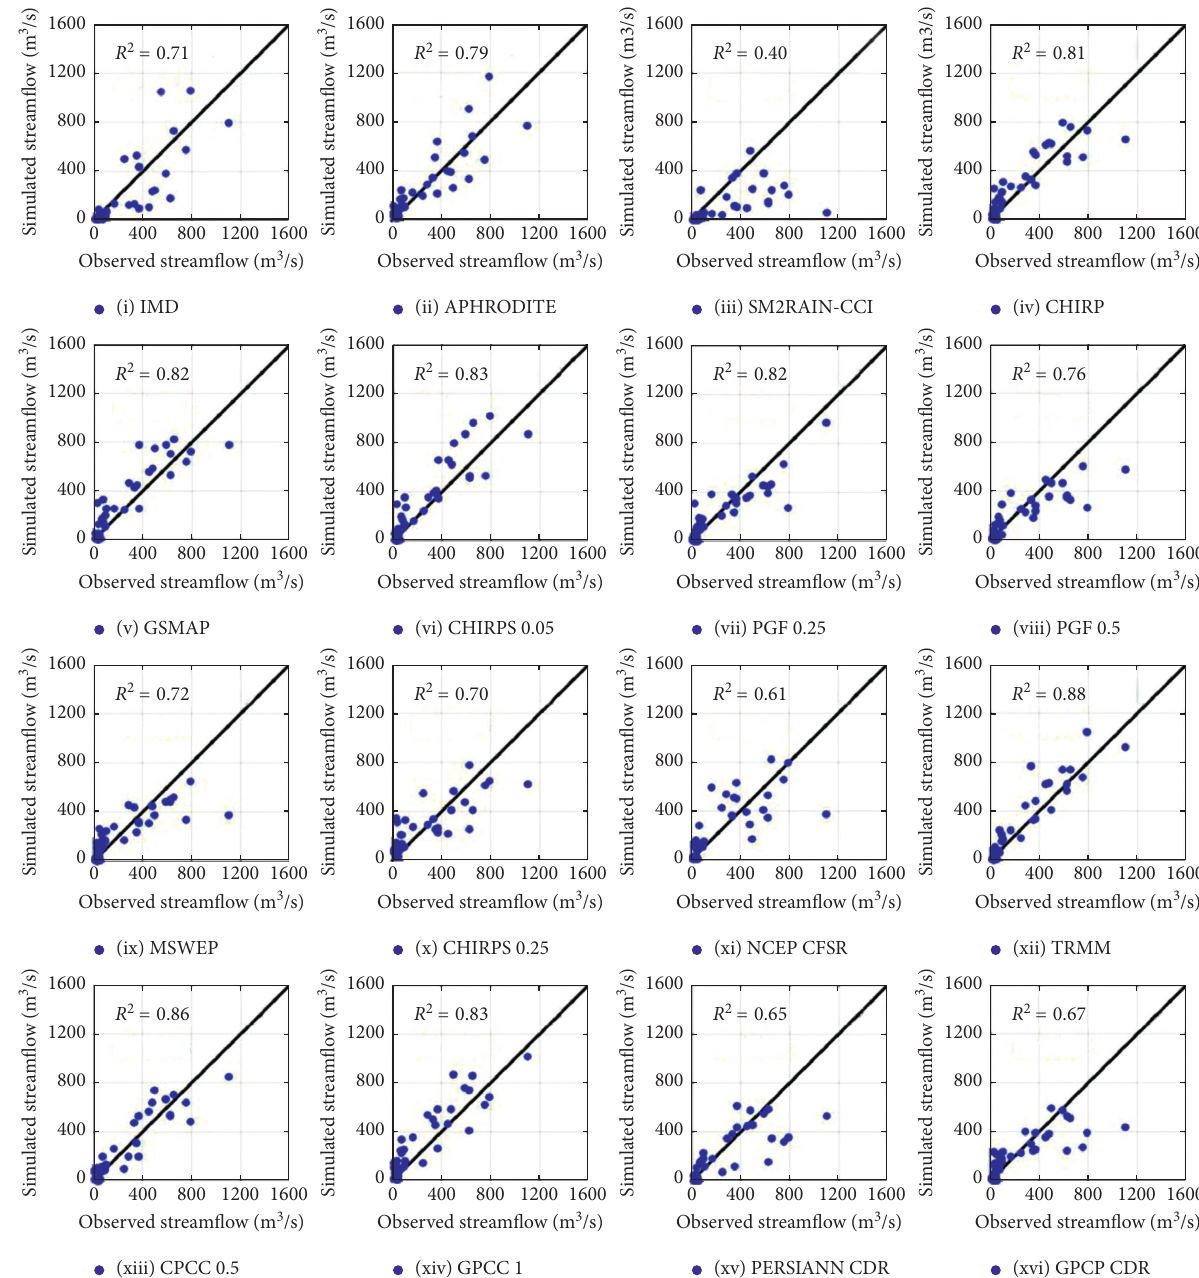
Figure 8: Scatterplots depicted for simulated versus observed runoff for (a) IMD, (b) APHRODITE, (c) SM2RAIN-CCI, (d) CHIRP, (e) GSMaP_Gauge_RNL v6, (f) CHIRPS 0.05 ° , (g) PGF 0.25 ° , (h) PGF 0.5 ° , (i) MSWEP, (j) CHIRPS 0.25 ° , (k) NCEP-CFSR, (l) TRMM 3B42 v7, (m) GPCC v7, (n) GPCC v2018, (o) PERSIANN-CDR, and (p) GPCP-CDR rainfall datasets during validation